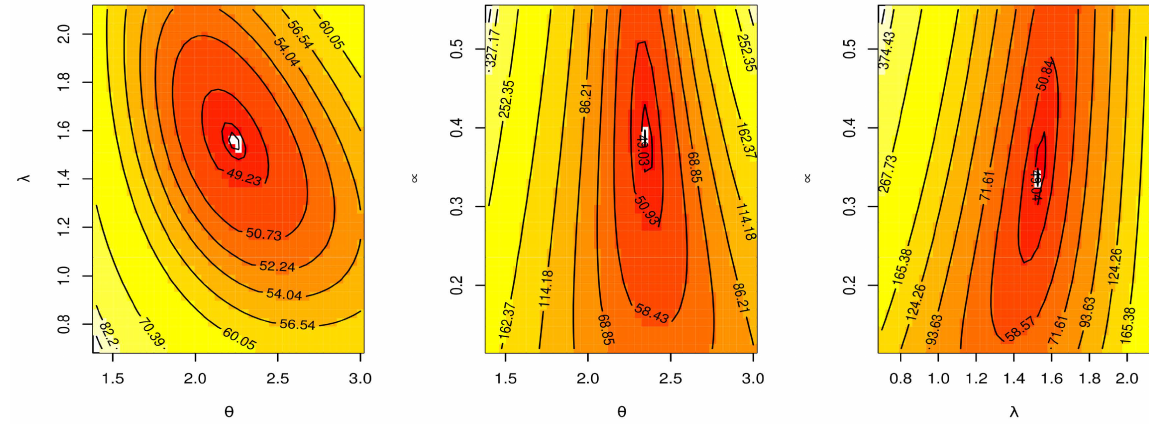
Figure 14. Likelihood profile for parameters of TCPWE distribution for COVID-19 data.